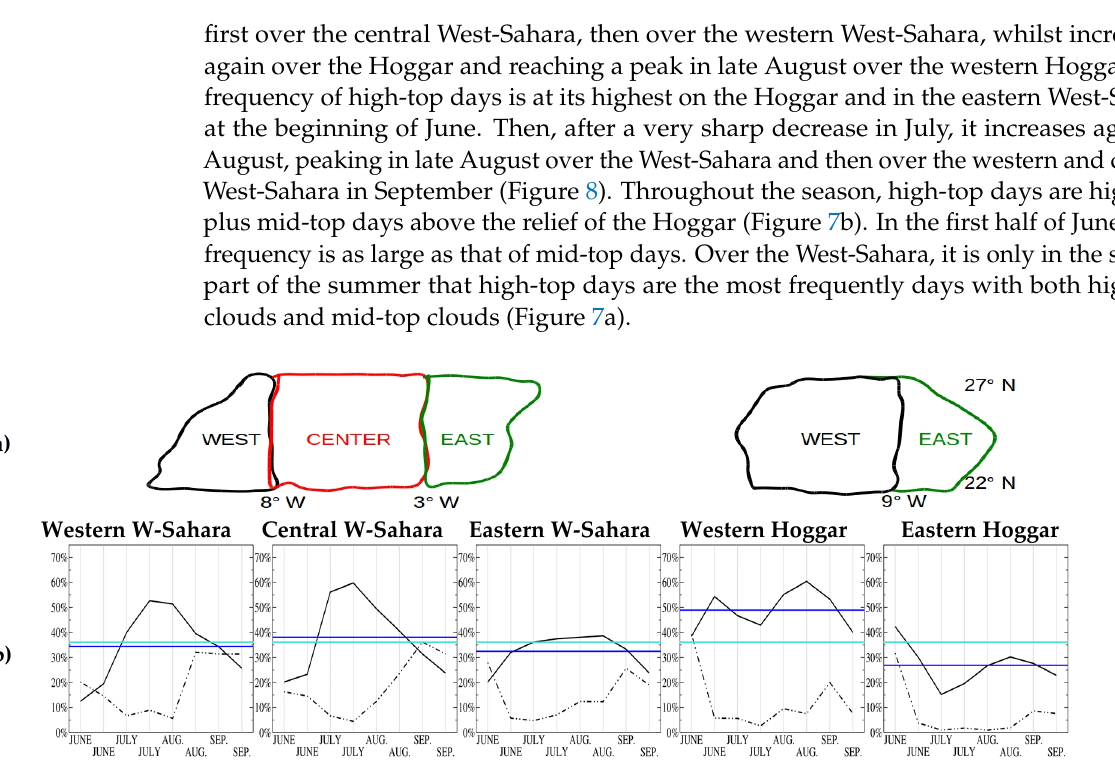
Figure 8. ( a ) Maps of the division of West Sahara in 3 sub-regions and of the Hoggar in 2 sub-regions. ( b ) Frequencies of mid-top days (solid line) and high-top days (dashed-dotted line) for each sub-region and for 15 day periods. Average frequency during JJAS (June to September) over the sub-region (blue line) and mean of the average frequency of the 2 Hoggar and 3 Western Sahara sub-regions (turquoise line).